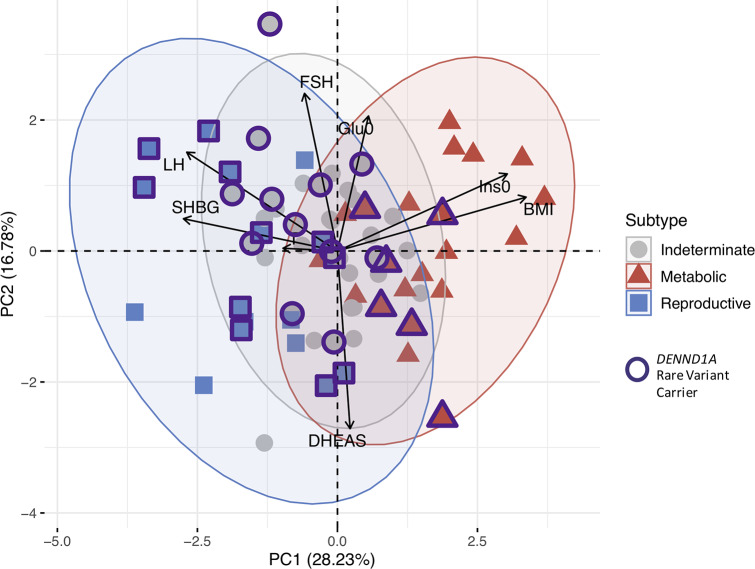
PCA of affected women in PCOS families showing DENND1A rare variant carriers.Affected women in PCOS families are plotted on the first 2 PCs of the adjusted quantitative trait data and colored according to their classified subtype. Markers outlined in bold represent DENND1A rare variant carriers. Subtype clusters are shown as 95% concentration ellipses, assuming bivariate normal distributions. The relative magnitude and direction of trait correlations with the PCs are shown with black arrows. BMI, body mass index; DHEAS, dehydroepiandrosterone sulfate; FSH, follicle-stimulating hormone; Glu0, fasting glucose; Ins0, fasting insulin; LH, luteinizing hormone; PC, principal component; PCA, principal component analysis; PCOS, polycystic ovary syndrome; SHBG, sex hormone binding globulin; T, testosterone.